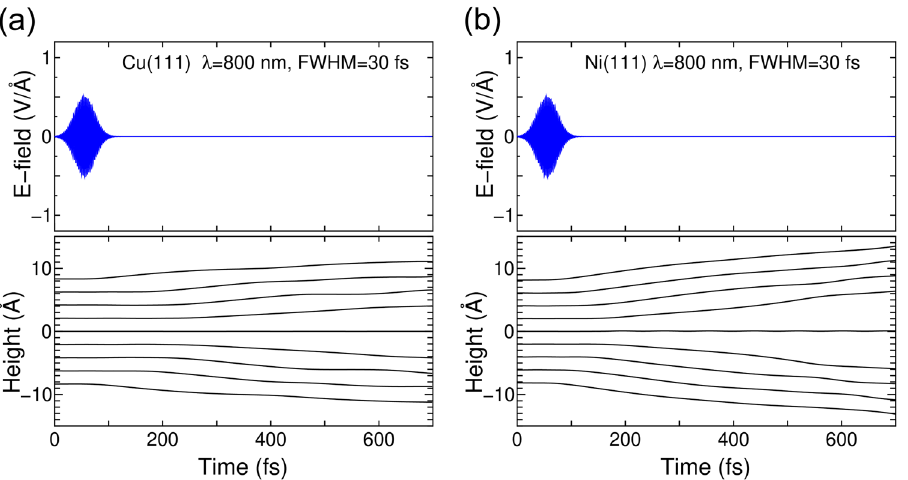
Figure 2. ( a ) TDDFT-MD simulation of a Cu slab upon a laser shot with wavelength of 800 nm, FWHM of 30 fs, and fluence of 0.1 J/cm 2 . The upper panel shows the time variation of the laser field polarized along the y axis of Fig. 1. The lower panel shows the dynamics of atomic height of each layer along the z axis of Fig. 1. ( b ) Same as ( a ) but for a Ni slab.